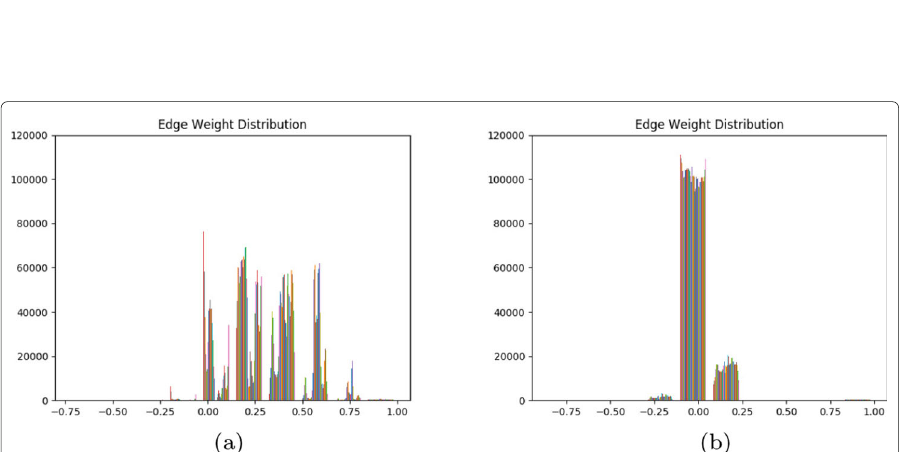
Fig. 3 Distribution of correlation and partial correlation coefficients over the dataset of 140 windows taken over the 17 year period. We can see that the partial correlation matrix generally has smaller values than the correlation matrix, and that they are more likely to be negative. a Correlation b Partial